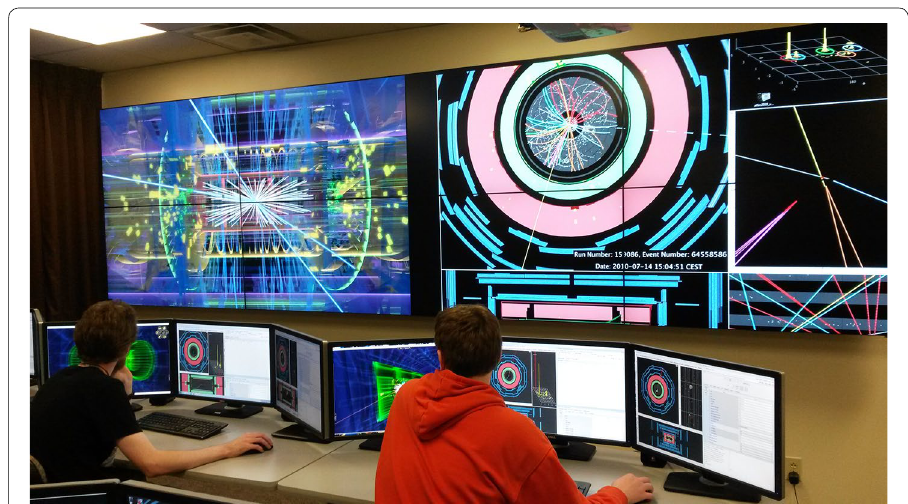
Fig. 6 Students analyzing particle tracks from HEP proton-proton collision